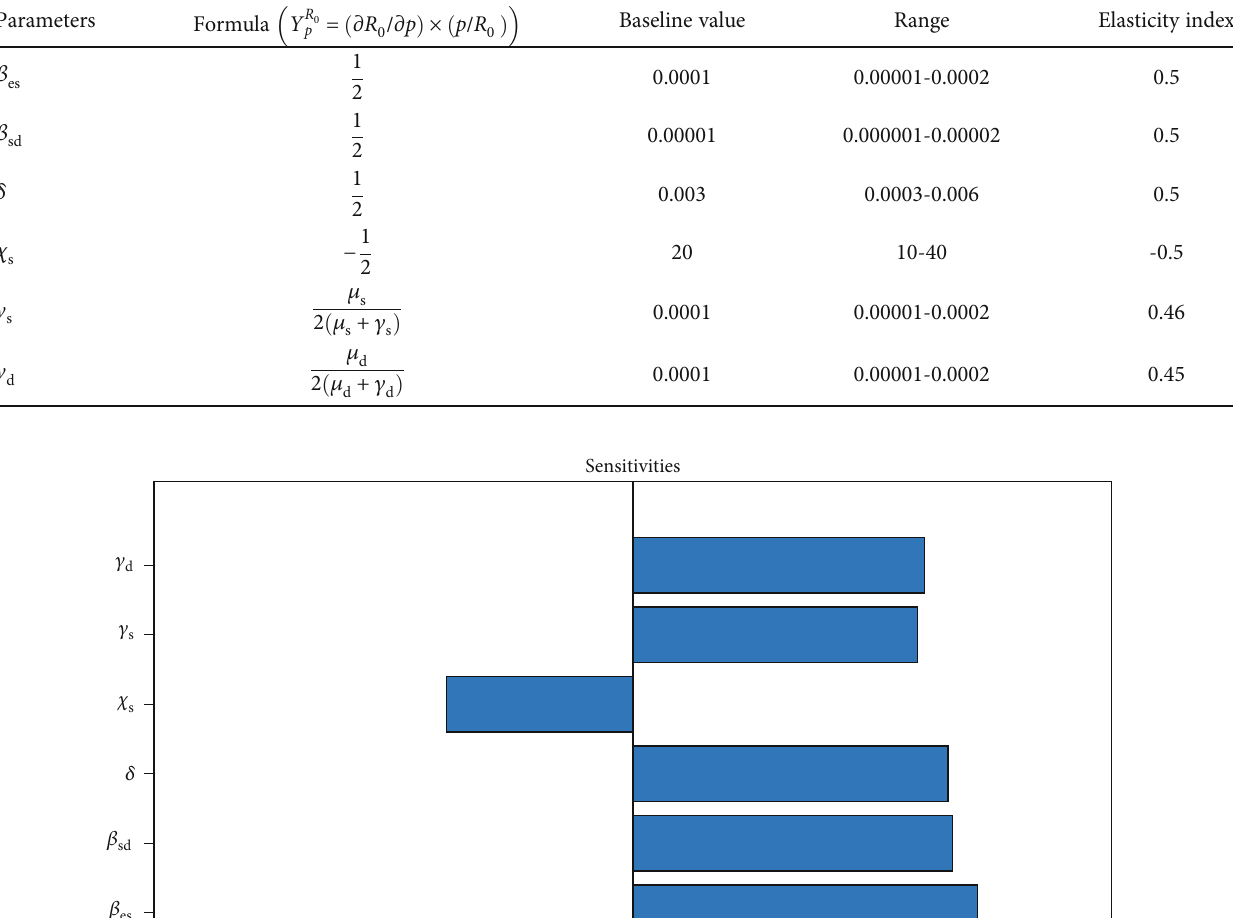
Table 4: Elasticity indices of R